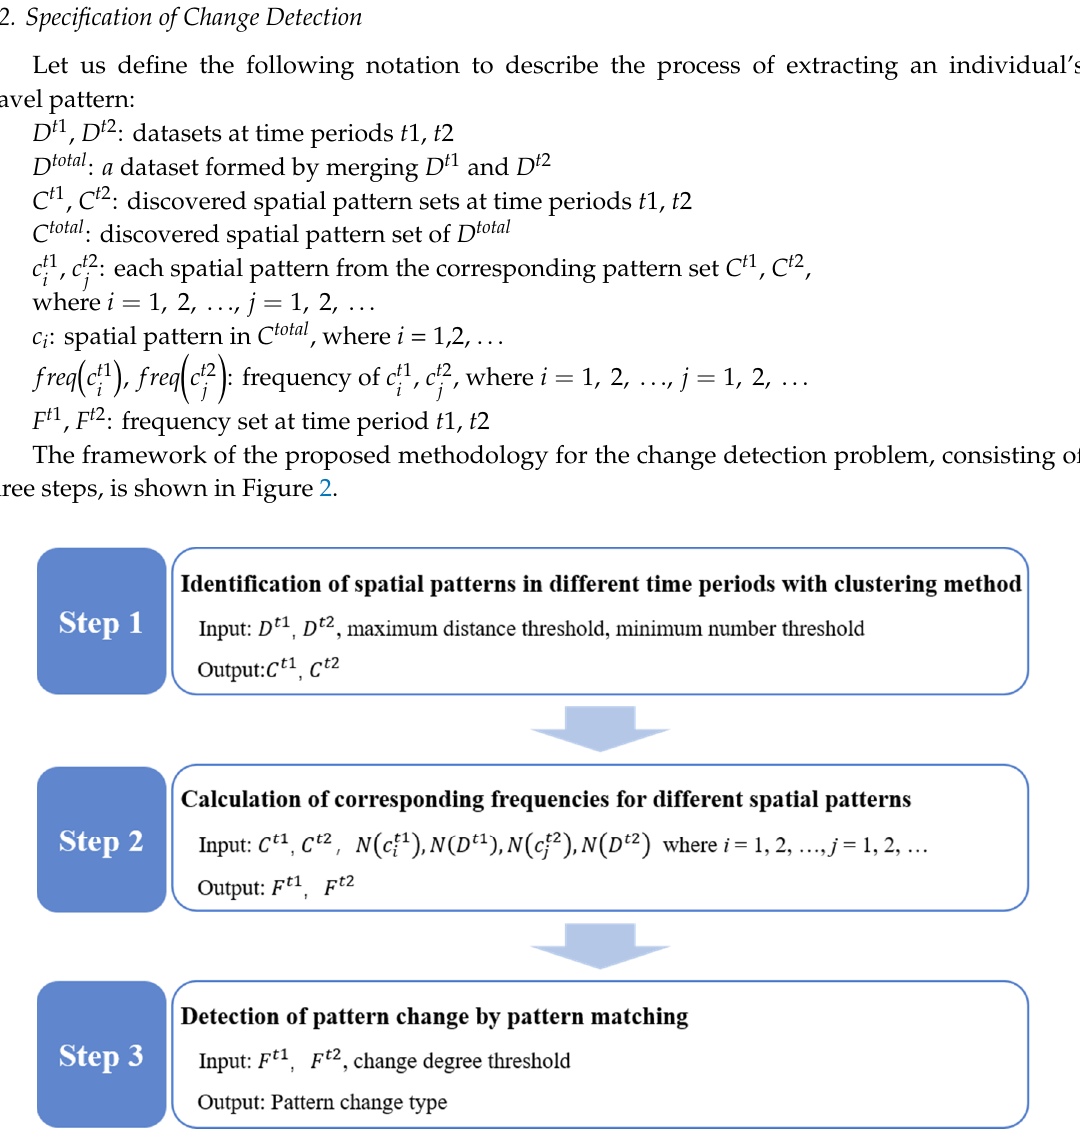
Figure 2. The framework of the change detection methodology.